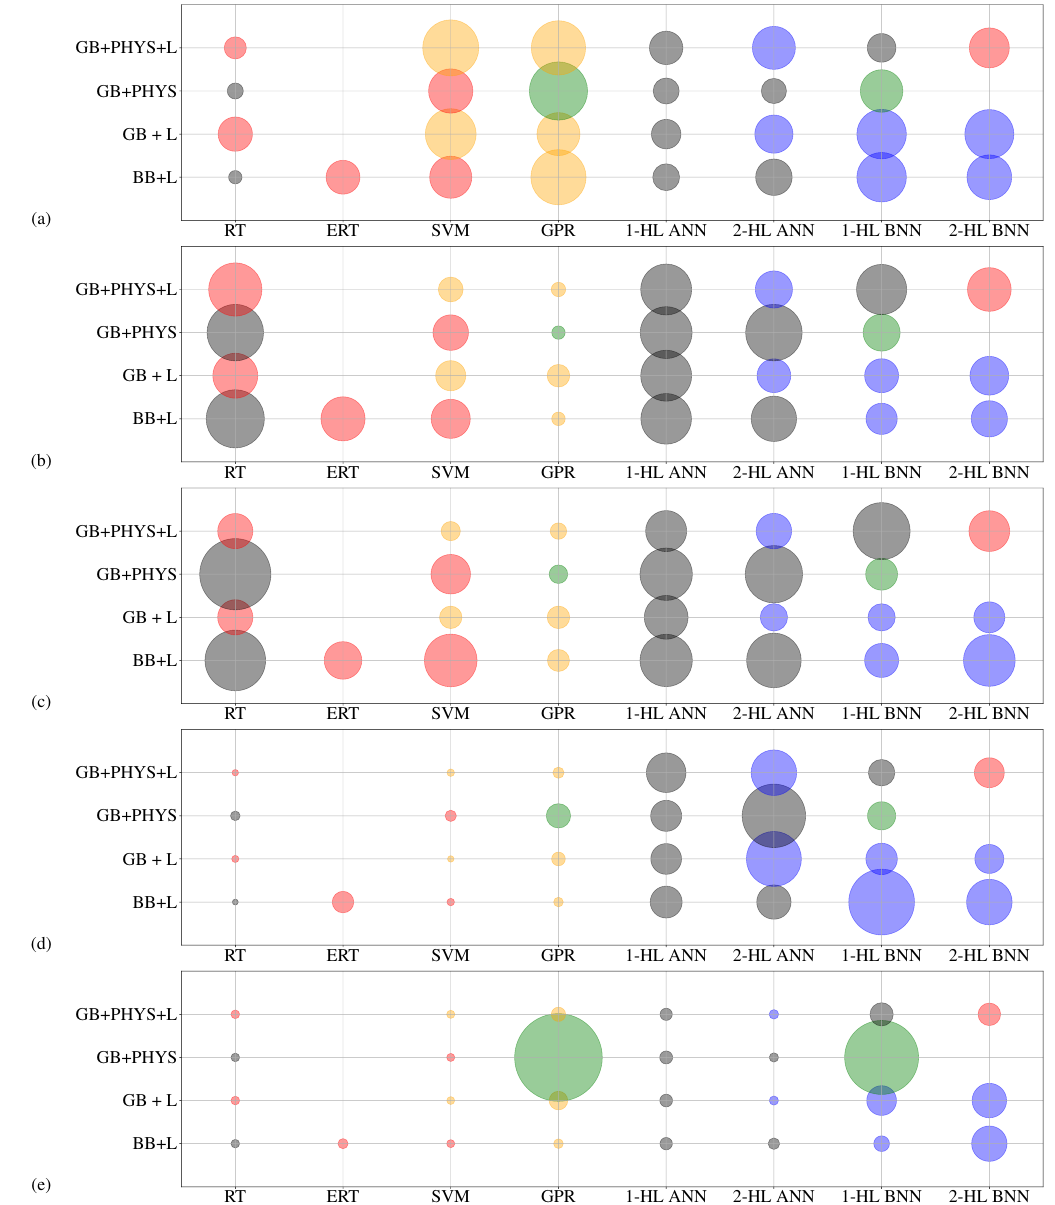
[ mg/m 3 ] , E test,max | |